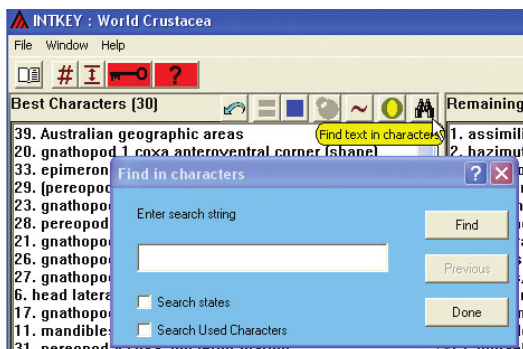
Figure 52. Find text in characters